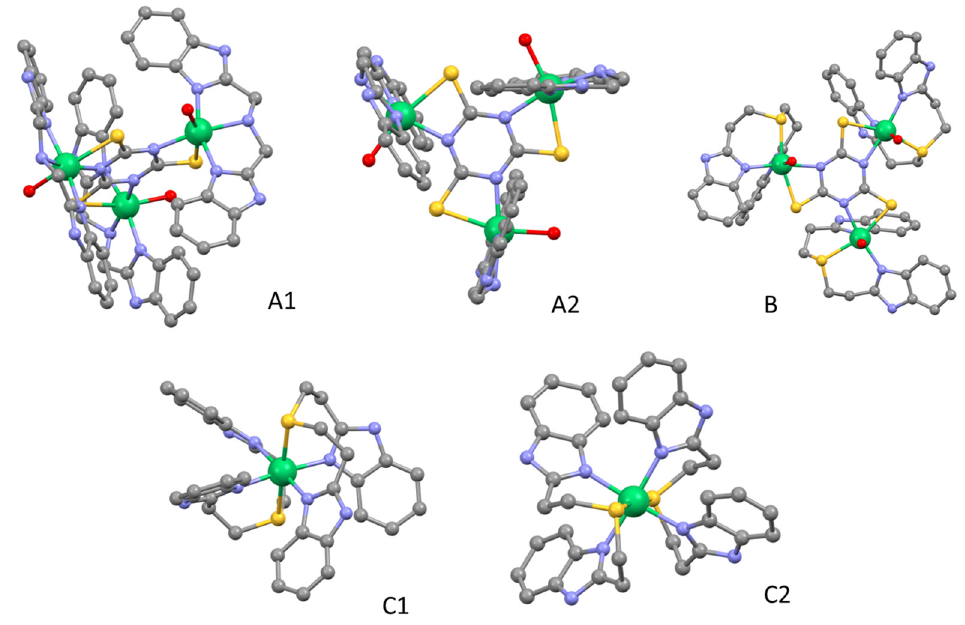
Figure 2. Molecular structures of complex cations: ( A1 , A2 ) [Ni 3 (abb) 3 (H 2 O) 3 ( µ -ttc)]; Ni (green), O (red), C (gray), N (blue), S (yellow), ( B ) [Ni 3 (tebb) 3 (H 2 O) 3 ( µ -ttc)], ( C1 , C2 ) [Ni(tebb) 2 ]. The abb = 1-(1 H -benzimidazol-2-yl)- N -(1 H -benzimidazol-2-ylmethyl)methanamine, ttcH 3 = trithiocyanuric acid, tebb = 2-[2-[2-(1 H -benzimidazol-2-yl)ethylsulfanyl]ethyl]-1 H -benzimidazole.